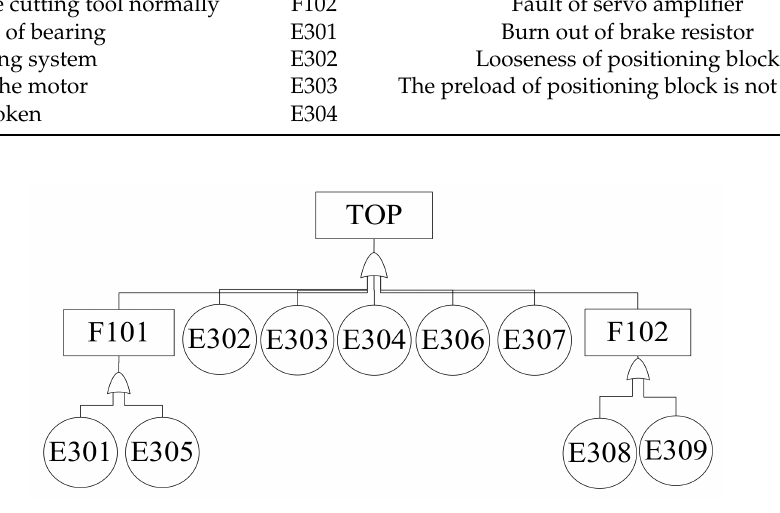
Figure 3. FTA of spindle system.